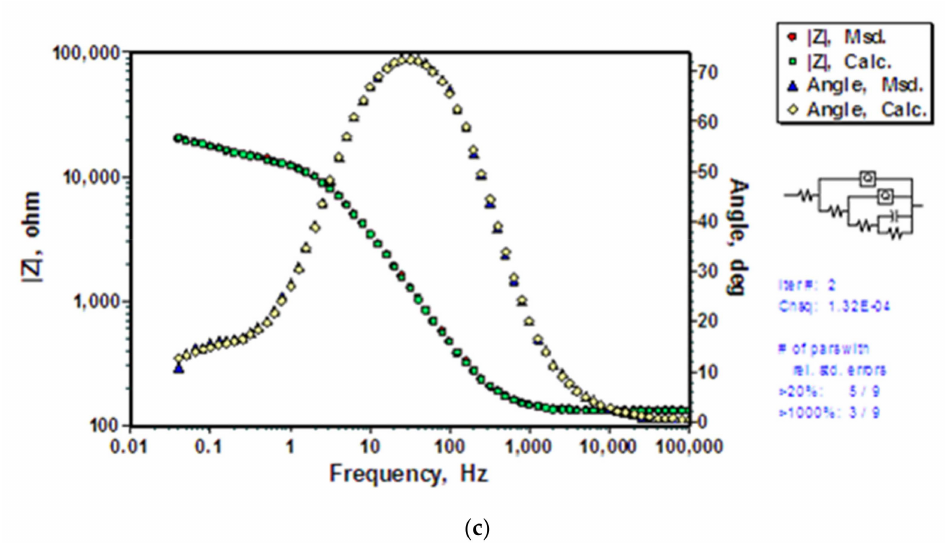
Figure 7. Experimentally measured Bode and phase angle plots and the corresponding data calculated using the electrical equivalent circuit, R s (Q Si (R Si (Q h (R h (C dl R dl ))))) for coated AZ91D alloy exposed to 0.1 M NaCl solution: ( a ) BTSE coating on substrate with no prior alkali treatment, ( b ) BTSE coating on substrate pre-polarized in hydroxide, and ( c ) BTSE coating on substrate pre-dipped in hydroxide for 48 h. Table 3. Corrosion of BTSE coated AZ91D, untreated, polarized in hydroxide and dipped in hydroxide, after immersion in